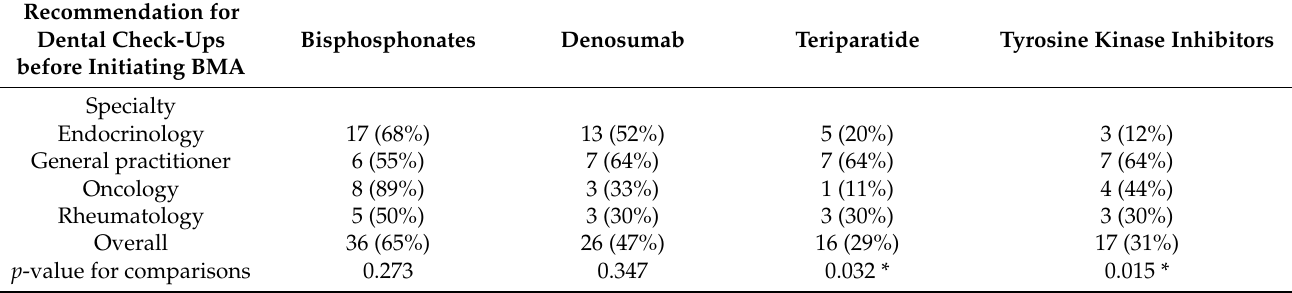
Table 5. Recommendations for dental check-ups before BMA initiation and comparisons between specialties. Significant differences are marked with